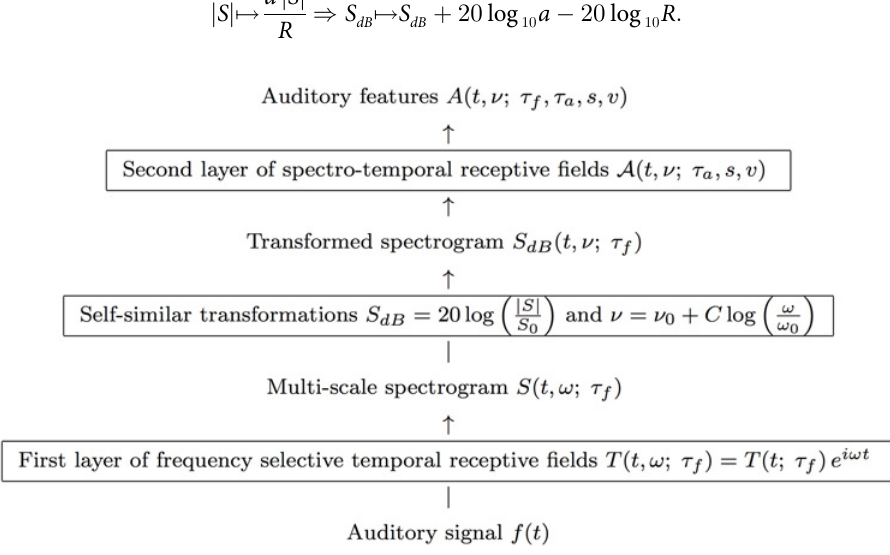
Fig 9. Schematic illustration of the definition of auditory features from a second layer of receptive fields over the spectrogram , where we also allow for a logarithmic transformation of the magnitude values j S j of the spectrogram prior to the application of the second layer of linear receptive fields and make use of a logarithmic transformation of the frequencies n ¼ n 0 þ C log ð o linear receptive fields over the spectro-temporal domain. Regarding the scale parameters, the first layer of temporal receptive fields depends on a single temporal scale parameter τ f for the frequency selective temporal filters, whereas the second layer of auditory receptive fields also depends on an additional temporal scale parameter τ a , a logspectral scale parameter s over the logarithmic frequencies ν and a glissando parameter v representing the rate by which the logarithmic frequencies may vary over time.